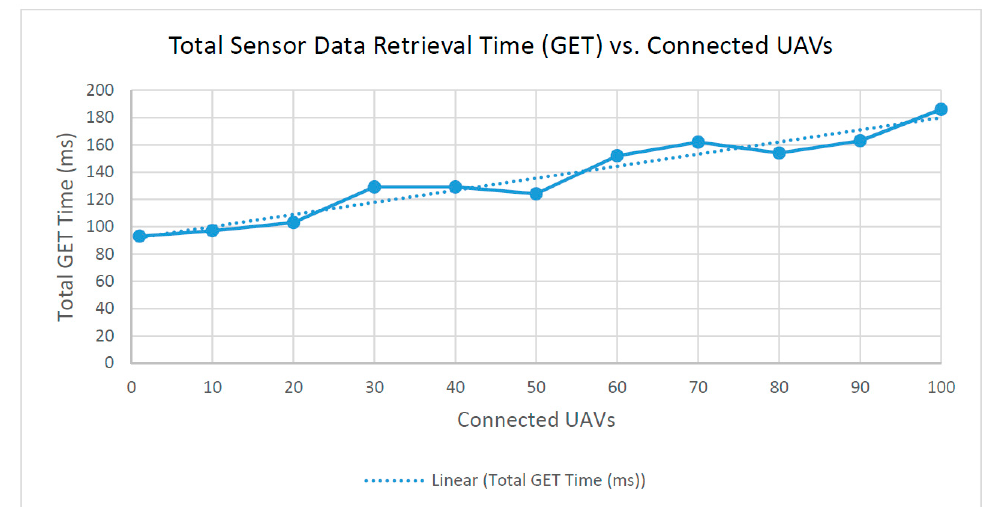
Figure 10. Total time to complete sensor data retrieval.